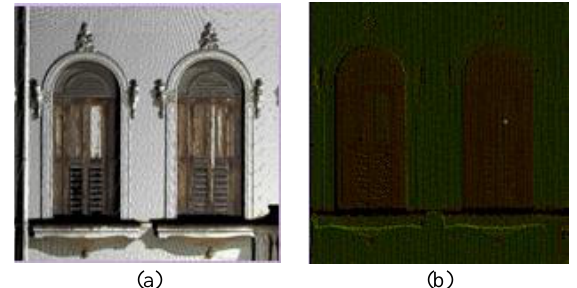
Figure 10: Detail of a Faro 120 (a) and of Leica C10 (b) scan on the same portion of an outer wall of the Villa. C10 laser points colored according to an intensity-based false color scale.